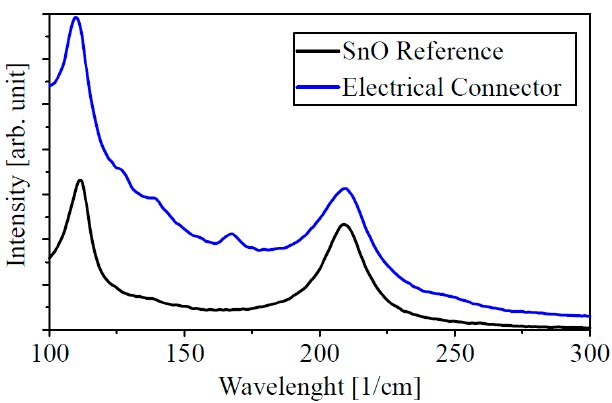
Figure 9. Raman Spectroscopy (laser-wavelength: 532 nm, power: 3 W) of a reference powder of tin monoxide (SnO) in comparison with an electrical contact stressed by vibration and temperature cycling test.